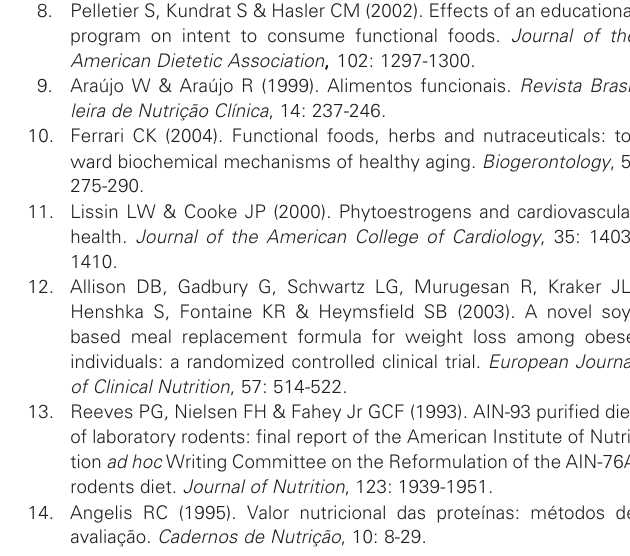
CG = control group fed a casein-based diet; OSG = organic soy group fed an organic diet supplemented with 0.3 g cysteine; GMSG = genetically modified soy group receiving a transgenic soy-based diet. Numbers followed by different superscript letter are statistically significant (P ≤ 0.05, ANOVA followed by Scheffé and Bonferroni